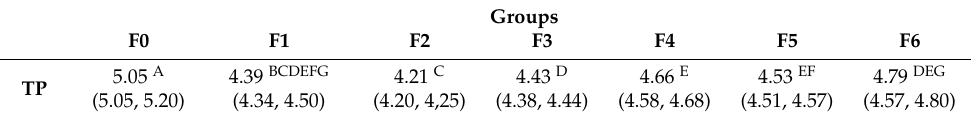
Figure 4. S. mutans cultured over zirconia specimens (F0–F6) for 24 h; fluorescence images and the area fraction of fluorescence in F0–F6. Table 2. Median translucency parameters of the experimental groups